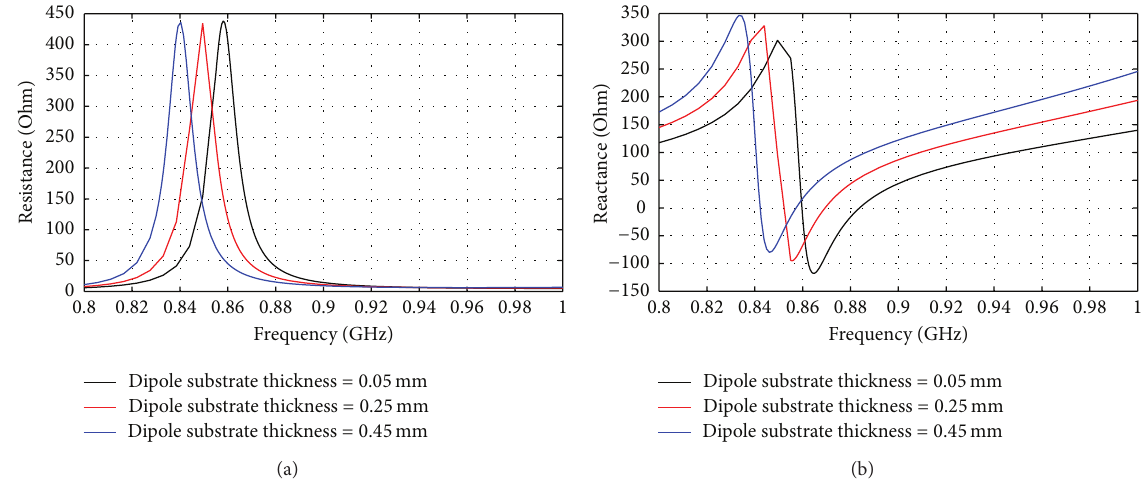
Figure 8: Tuning the real and imaginary parts of the input impedance by varying the height of the superstrate layer.